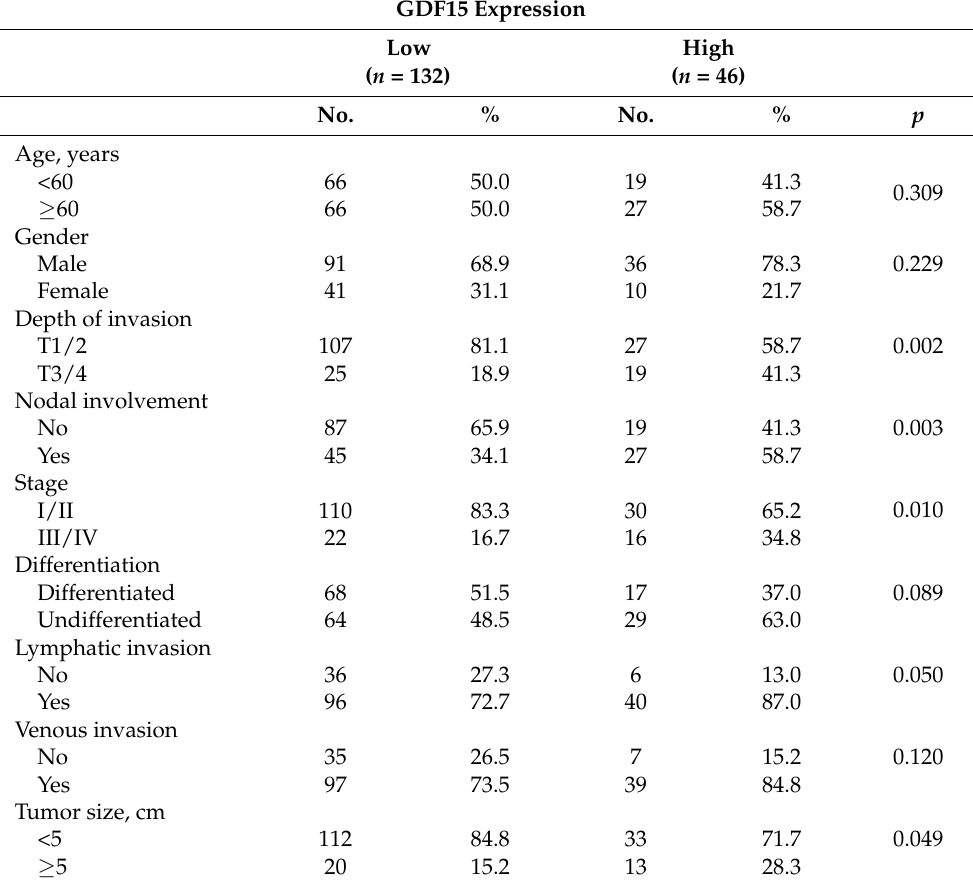
Table 1. Associations of the expression of GDF15 in patients with gastric cancer.